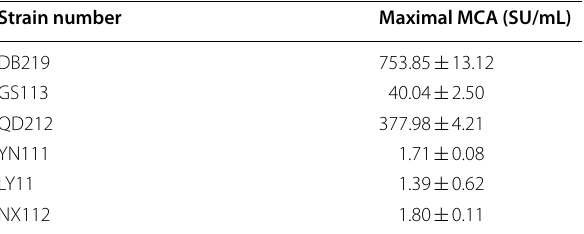
Table 2 The maximal MCA of strains in wheat bran